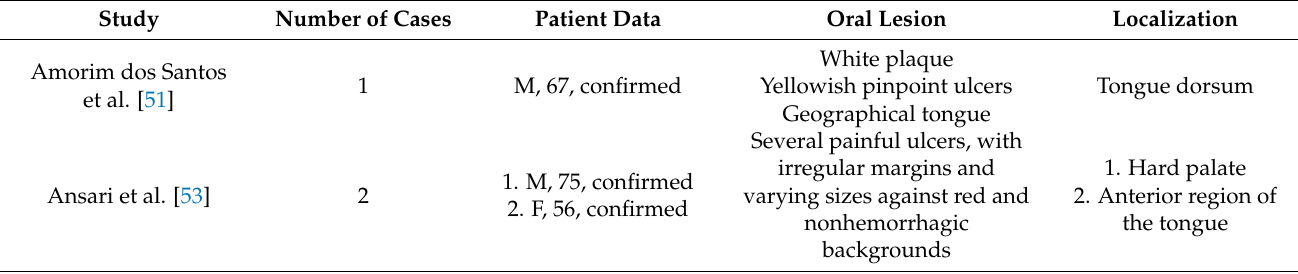
Table 1. Main aspects of the included